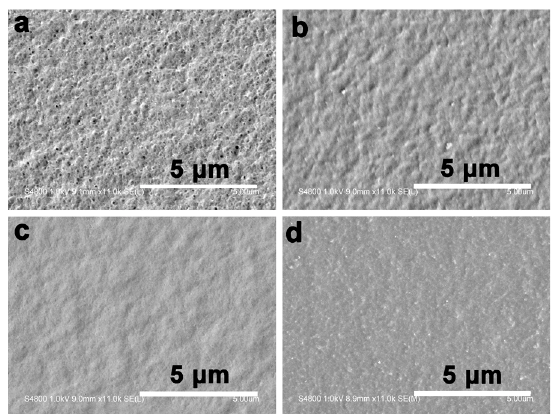
Figure 1. Scanning electron microscopy (SEM) image of the surface morphologies of the composite films. ( a – d ) are for RCBEA5, RCBEA15, RCBEA35, and RCBEA50, respectively.